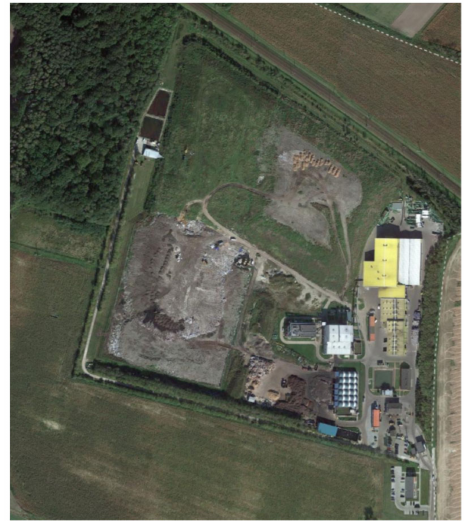
Figure 1. Active municipal waste landfill in Kiełcz.